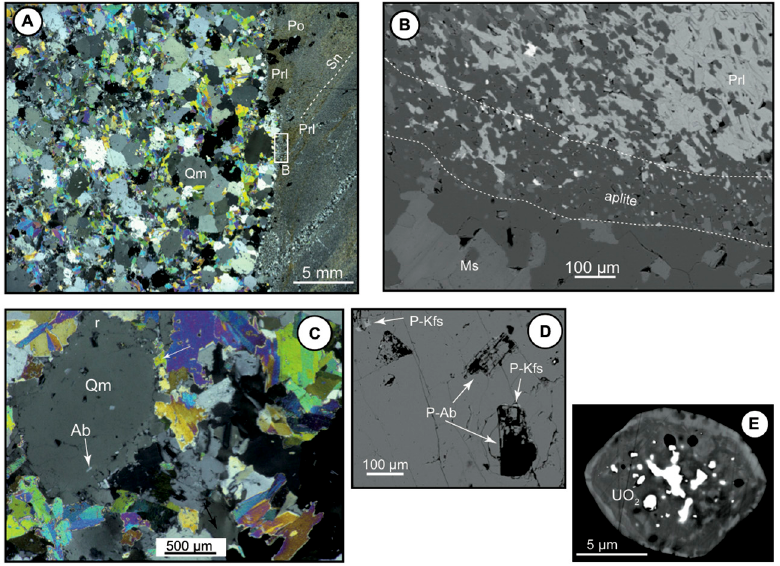
Figure 4. Photomicrographs and SEM-BSE images of the greisen cupola at the L2 level. ( A ) Granite (greisenised) / wallrock contact (cross-polarized light, sample PNQ-13a). Starting from the contact, protolithionite (Prl) is invading the wall rock, thanks to the schistosity (Sn); Po: pyrrhotite. ( B ) SEM-BSE image of the granite-schist contact (located in A). A thin aplite rim is intercalated at the contact. Together with quartz and albite, it contains minute inclusions of muscovite, protolithionite, and rutile (bright spots). ( C ) Relic embryonic snowball quartz in the greisenised G4 granite (sample PNQ-13a, cross-polarized light). The small included albite (Ab) in the magmatic quartz (Qm) defines the “snowball” texture. Note the secondary quartz expansions (r) around the magmatic quartz, and the interplay of muscovite and this rim (arrow). ( D ) SEM-BSE image of included P-enriched albite (P-Ab) and Kfs (P-Kfs) in the magmatic quartz (sample PNQ-19a). ( E ) Zoned zircon in the muscovite at the L2 level (BSE, sample PNQ-17a). Note the numerous uraninite inclusions. The rim is depleted in Hf and U-rich. Note the great difference with the G1 zircon (Figure 10D).